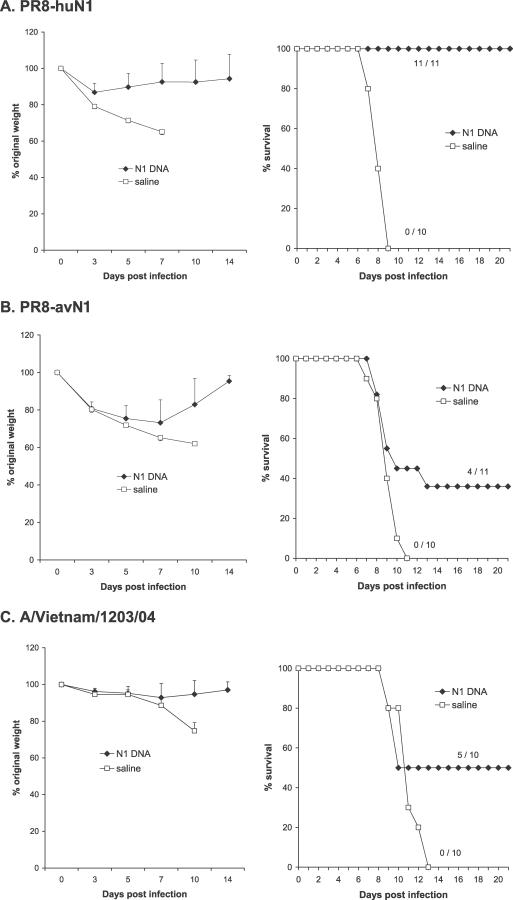
Challenge of huN1-Immunized Mice with Influenza Viruses Possessing Homologous or Heterologous NA GenesMice immunized twice with huN1 DNA or saline alone (control) were inoculated intranasally with PR8-huN1 (A), PR8-avN1 (B), or A/Vietnam/1203/04 (C). Mean weight change and survival data are shown. Differences in survival between huN1 DNA-vaccinated and saline control groups were statistically significant for PR8-huN1 challenge (p < 0.001) and A/Vietnam/1203/04 challenge (p = 0.016), and approached but did not reach significance for PR8-avN1 challenge (p = 0.055). Error bars represent standard deviation values. Statistical comparisons are by Fisher's exact test.